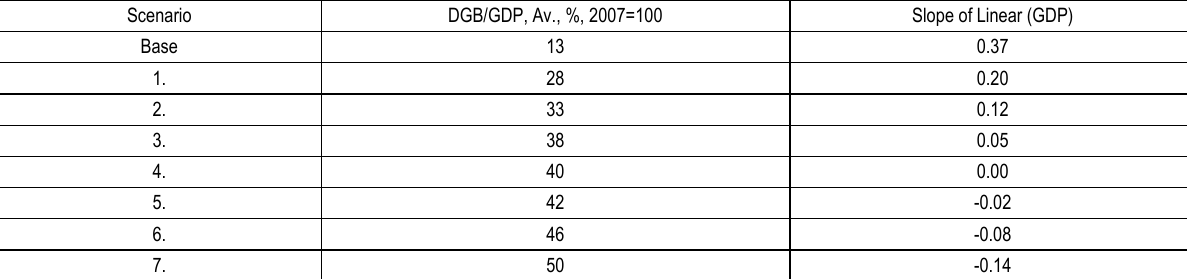
Table 1. The scenario verification of the threshold ratio (Q1 2008 ‒ Q4 2013)